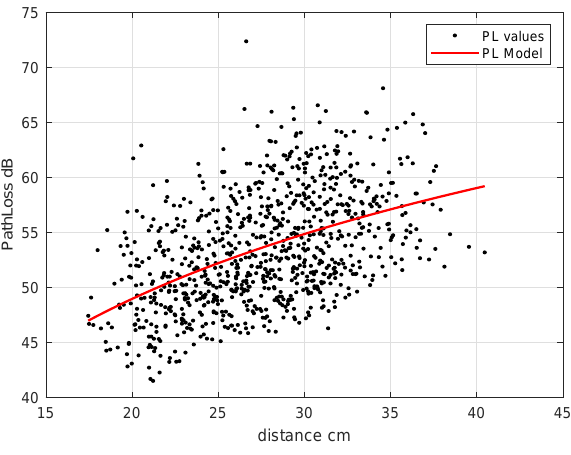
Figure 12. Path-loss eavesdropper link (IB2OFF,